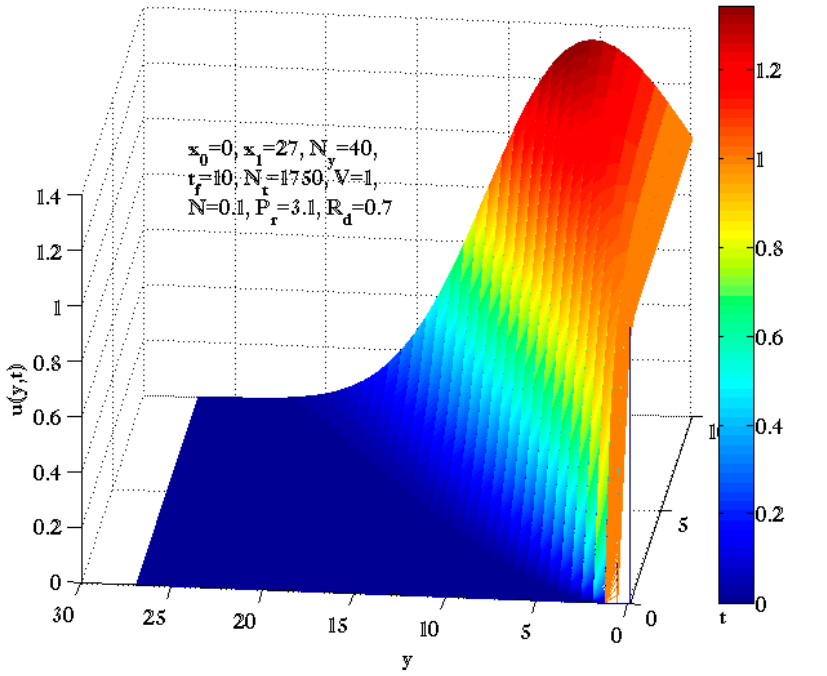
Figure 8. Contour plot for velocity using (cid:1848) = 2.